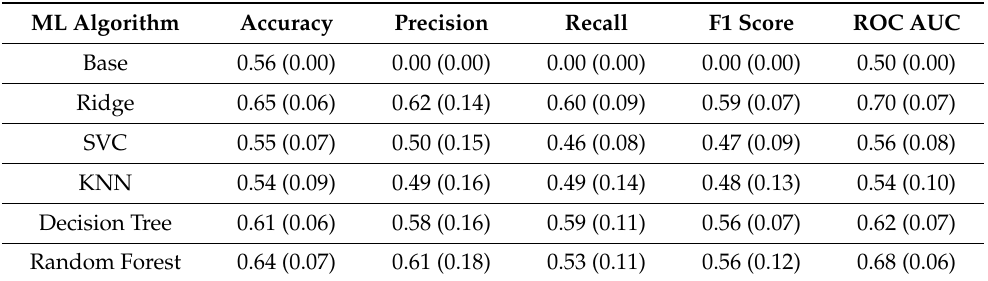
Table 12. HO prediction results (classification problem) using I-F and U-F features. Nested cross- validation with 10 outer and five inner splits. Classification problems on two classes: (a): High_HO (High Hedonic Orientated) and (b): Low_HO (Low Hedonic Oriented). Numbers are the mean value of 10 outer splits. Numbers in parenthesis indicate the standard deviation